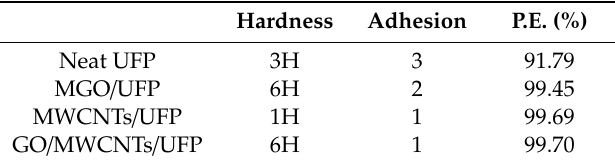
Table 1. Physical-mechanical properties.